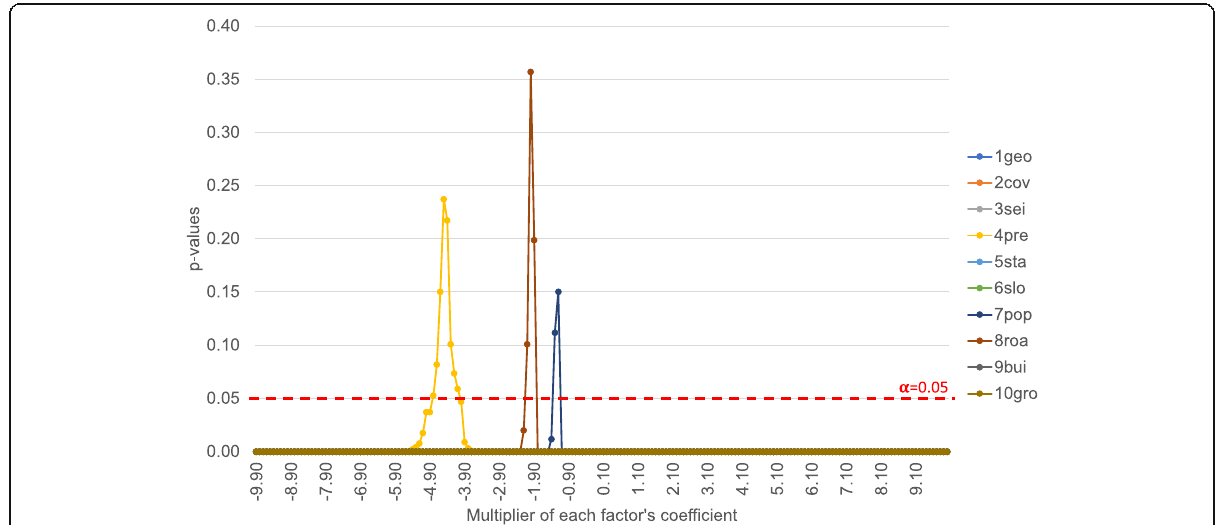
Fig. 6 This shows the p -values of the K-S test (two-sample) applied to 2000 landslide susceptibility datasets resulting from the univariate susceptibility analysis of the LOGIT model by weights discretization. Legend: The alpha value to determine the significance level was 0.05, which is marked with the dashed red line. The values (dots) above this level ( precipitations, population, and road density ) represent the non-significant samples from 13 simulations, whereas the remaining 1987 are considered to be at significance levels. The building footprint factor dots (ochre color) cover most of the dots representing these remaining simulations, which are very close to a p -value of zero. Lines with dots represent factors: 1geo = lithology (electric blue), 2cov = land use/vegetation coverage (orange), 3sei = seismicity (light gray), 4pre = precipitations (yellow), 5sta = soil stability (light blue), 6slo = slope (green), 7pop = population (dark blue), 8roa = road density (brown), 9bui = floor area (dark gray) and, 10gro = building footprint area (ochre). X-axis shows the multipliers of each factor ’ s coefficient and Y-axis shows the p